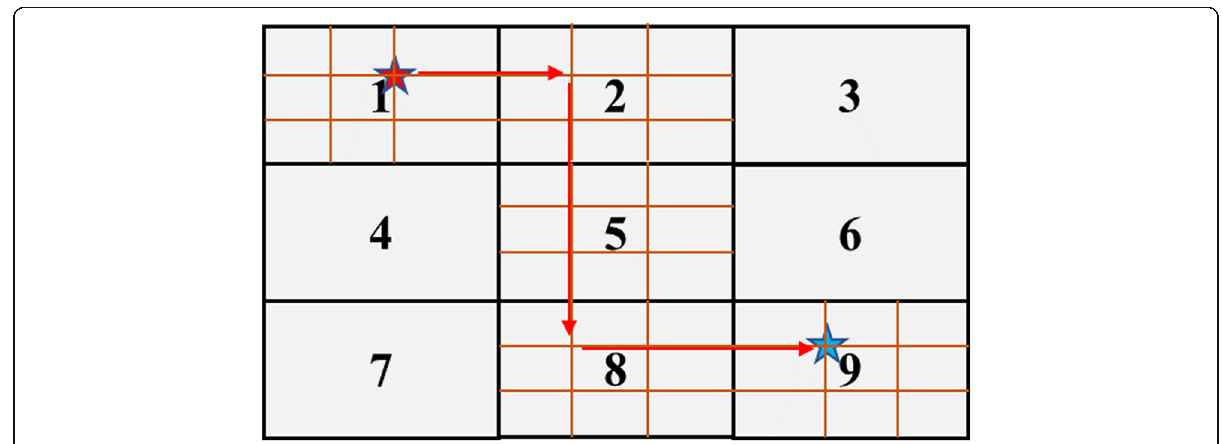
Fig. 2 Schematic diagram of lower-level path